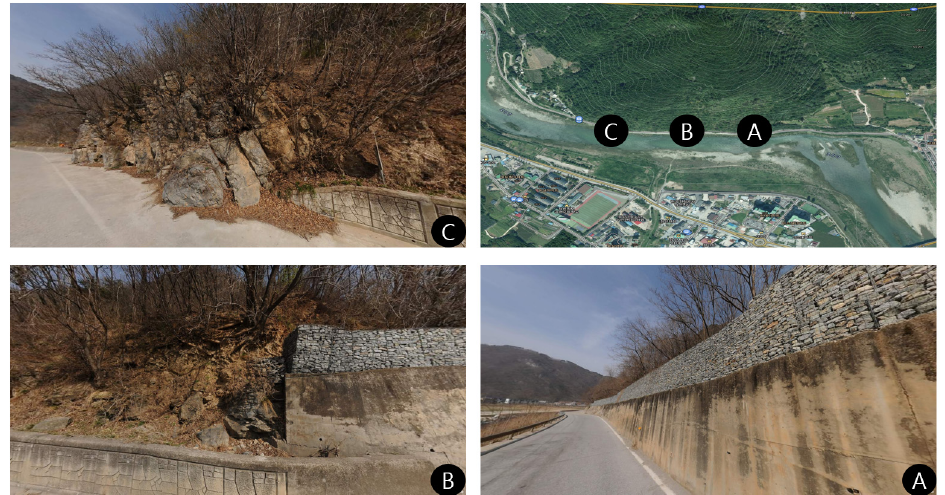
Figure 12. GGSJ management district with a length of 500 m .